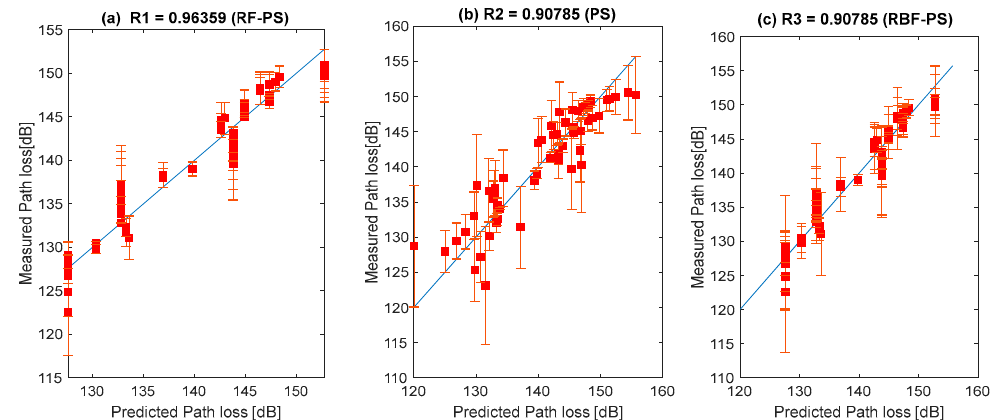
Figure 20. Results showing the correlation between the measured path loss and predicted path loss using the hybrid RF-PS prediction method and two existing standard path loss prediction methods in site 1 of location 1.